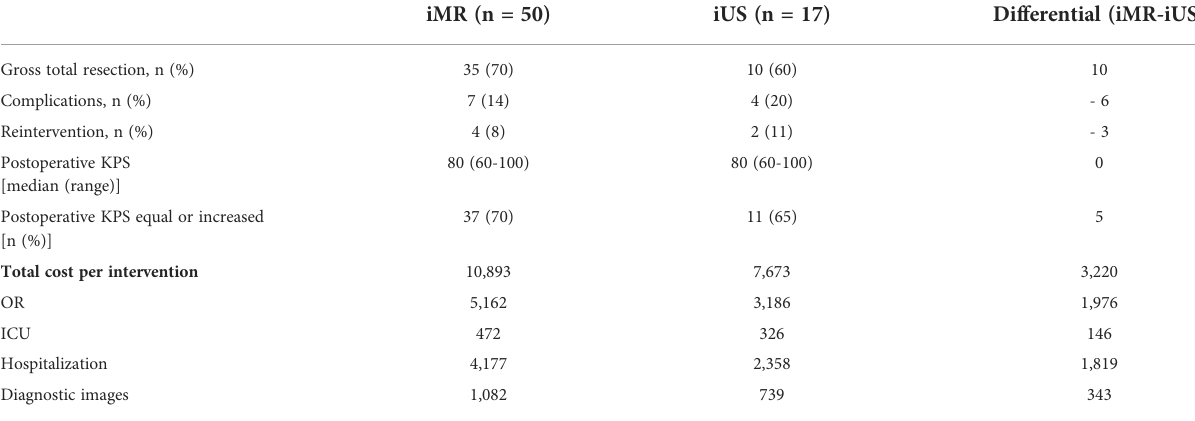
TABLE 2 Clinical outcomes and total cost per intervention